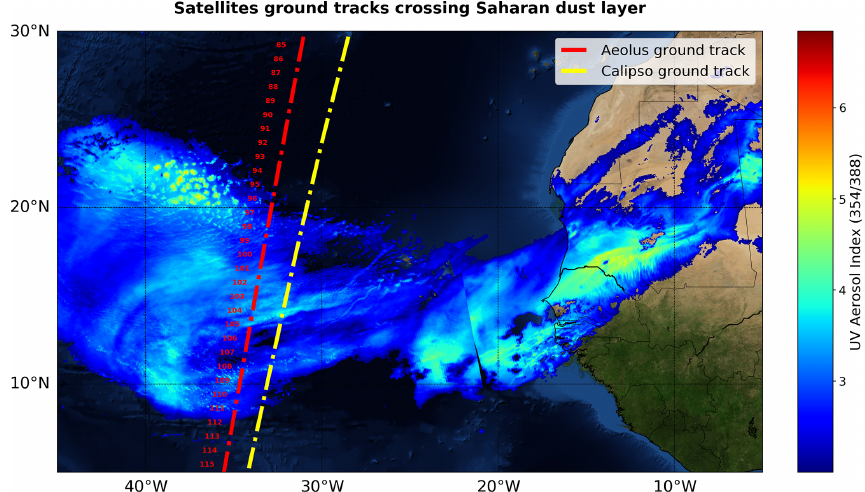
Figure 14. West African coast and northeast Atlantic Ocean from the ArcGIS World Imagery online basemap (Esri et al., 2021) overlaid with Aeolus (dashed red line) and CALIPSO (dash-dotted yellow line) ground tracks and BRC number between 08:08 and 08:16UTC and Sentinel-5P UV aerosol index for the 354/388nm pair of